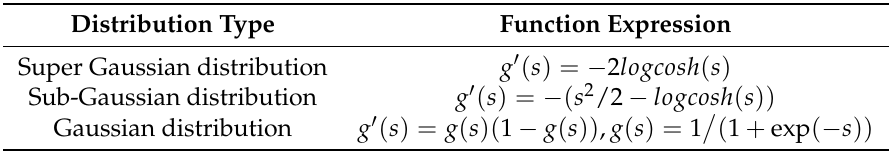
Table 2. Probability density function (PDF) corresponding to different